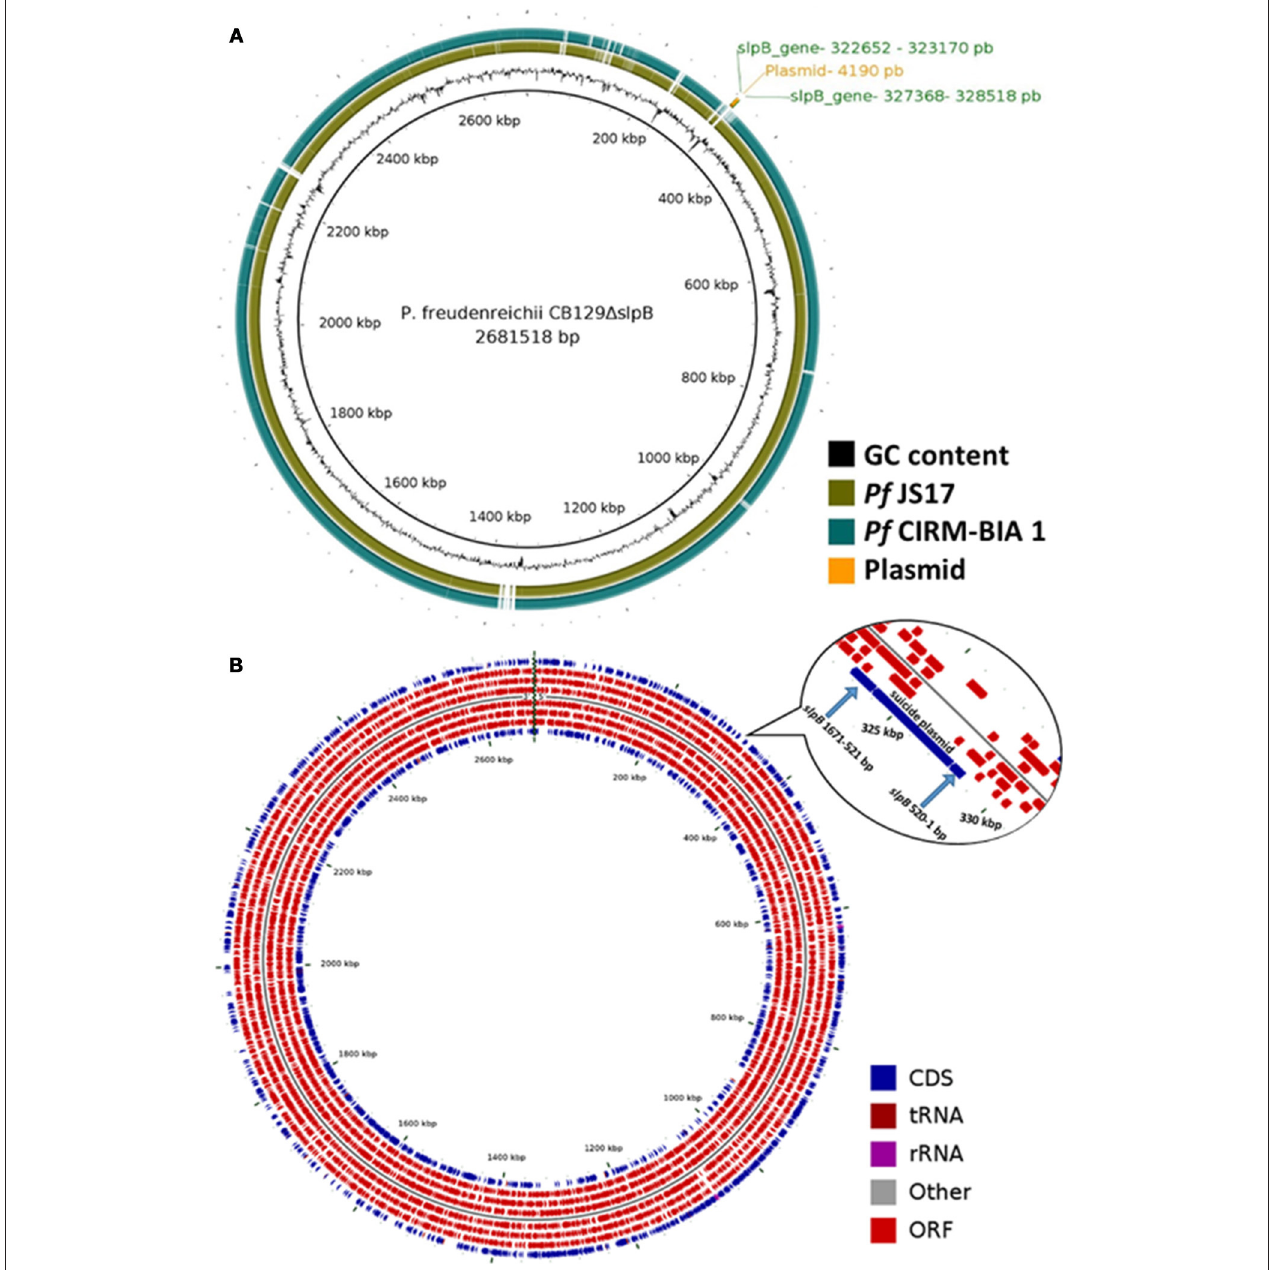
FIGURE 6 | Comparative genomic map generated with BRIG and Map of Circular genome generated with CGview. (A) P. freudenreichii CIRM-BIA 1 and P. freudenreichii JS17 were aligned using CB129 1 slpB strain as a reference. (B) In the outermost ring the genes localization in genome, followed by CDS, tRNAs, rRNAs, other RNAs, and CDSs. The insertion site of the plasmid for the slpB gene mutation is visualized in the zoom